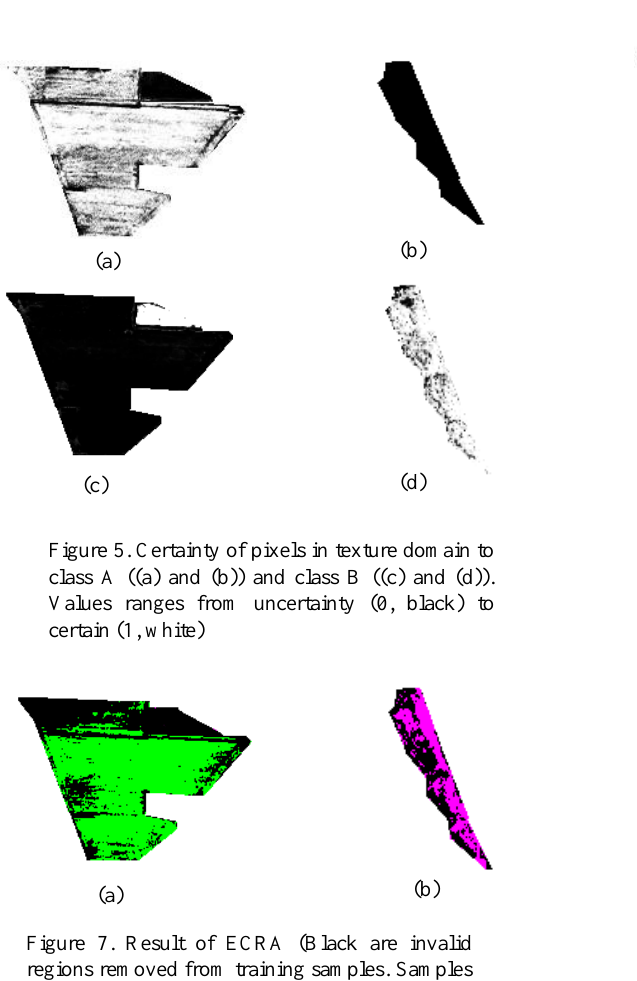
Figure 3. False color composite of WorldView-2 imagery of two crop fields used for training, (a) winter rape, class A and (b) grass below normal yield, class B while (c) and (d) represents pixel labels inside respective crop fields